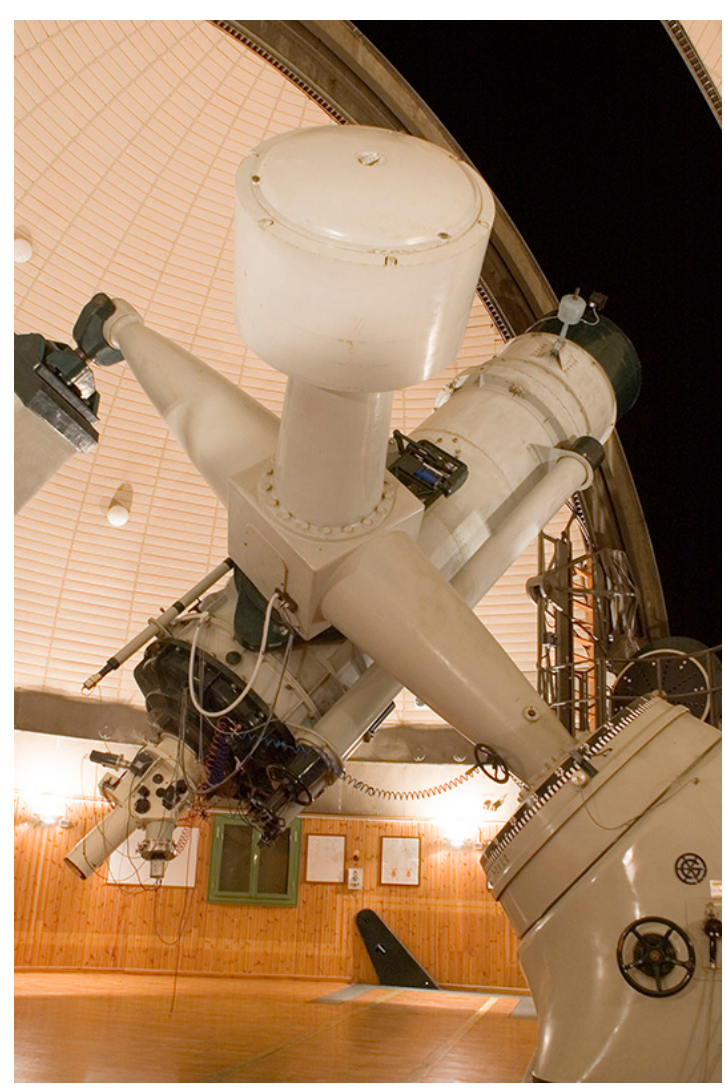
Fig. 1. The 1.22 m telescope of the Asiago Astrophysical Observatory (University of Padova), dedicated to Galileo Galilei. Erected in 1942, at that time the largest in Europe, it has been recently completely refurbished and now it is remotely operated with a minimal in situ technical support. The main instrument is a Boller & Chievens spectrograph and a large format CCD, with the whole optical train optimized for high ultraviolet sensitivity. In addition to active research programs, the telescope is accessed regularly by outreach programs and student training sessions. 9. The first symbiotic star studied with the 1.22 m telescope was T CrB at the time of its 1946 outburst. The measurements appeared in the form of a short note written by S. Taffara in the Contributions of the Asiago Observatory